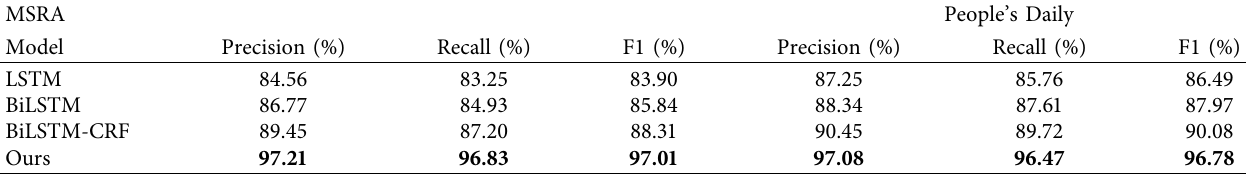
Table 3: Comparison results between the model in this article and the basic